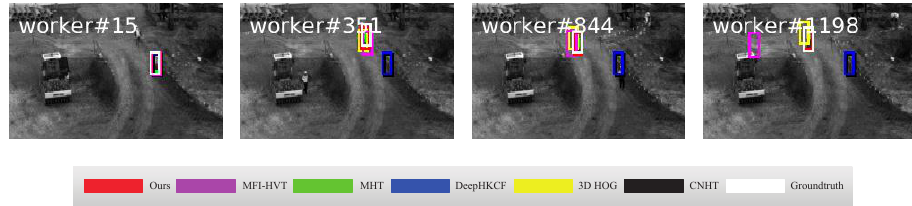
Figure 15. Qualitative results on the truck sequence.